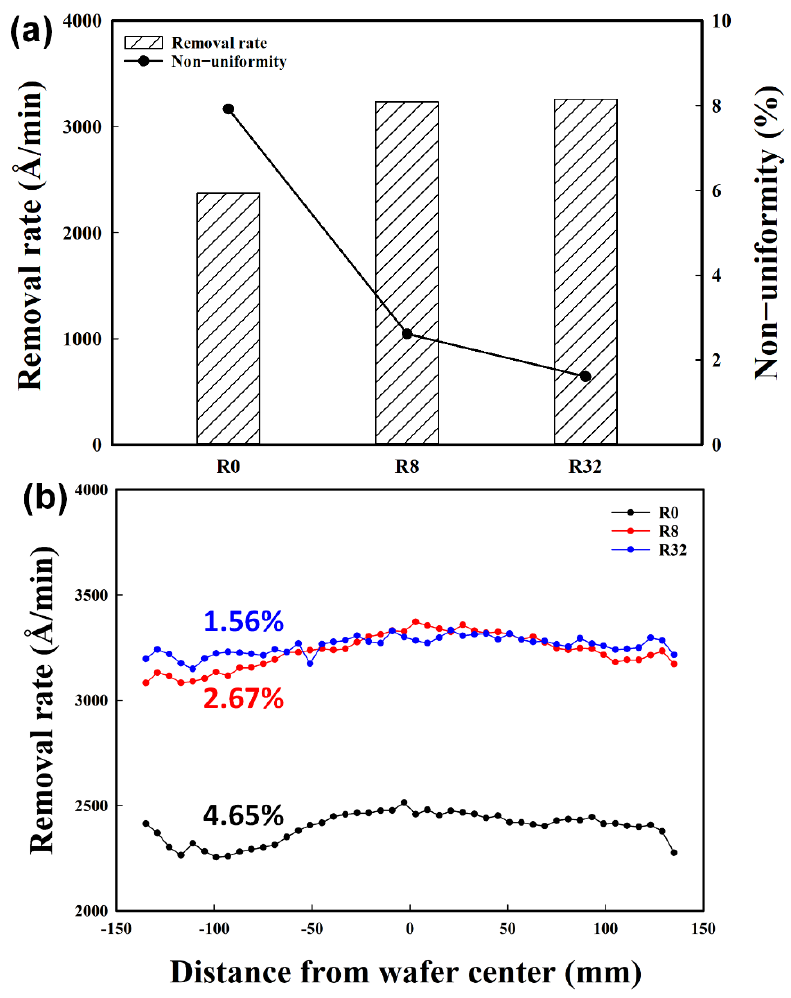
Figure 11. ( a ) The material removal rate and non-uniformity of 300 mm wafers polished with the R0, R8, and R32 pads. ( b ) Profiles of wafer surfaces polished with the different pads.